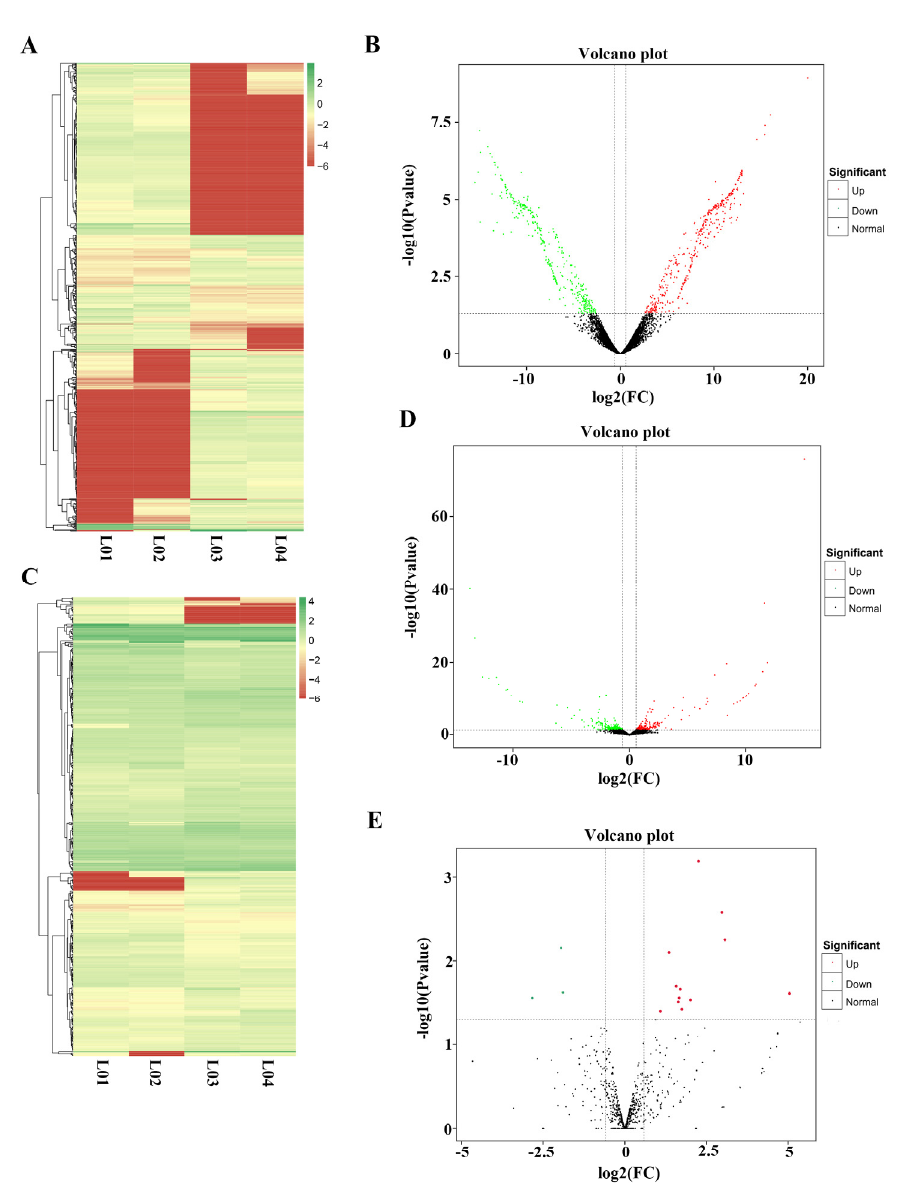
Figure 4. Analysis of differential gene expression before and after GnRH treatment. ( A ) Differential expression analysis of four groups of lncRNAs. ( B ) LncRNA expression volcano plot. ( C ) Differential expression analysis of four groups of mRNAs. ( D ) mRNA expression volcano plot. ( E ) miRNA expression volcano plot.